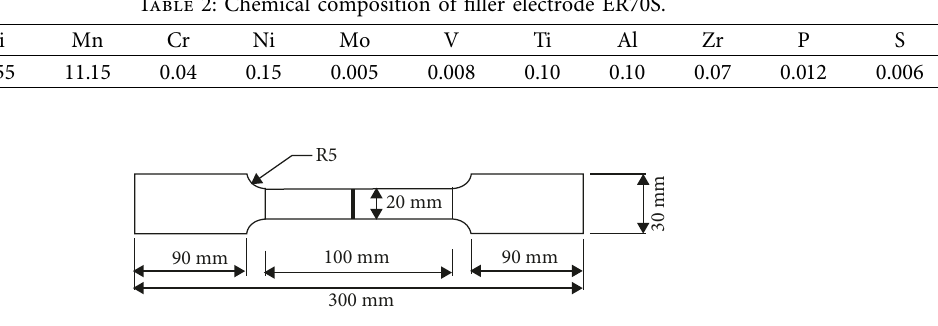
Figure 1: Sample for tensile test. Table 3: Process parameters and their levels.